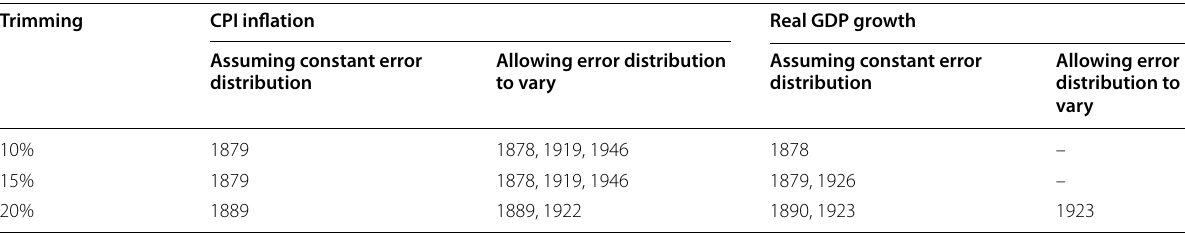
Table 5 Bai-Perron breakpoint test results